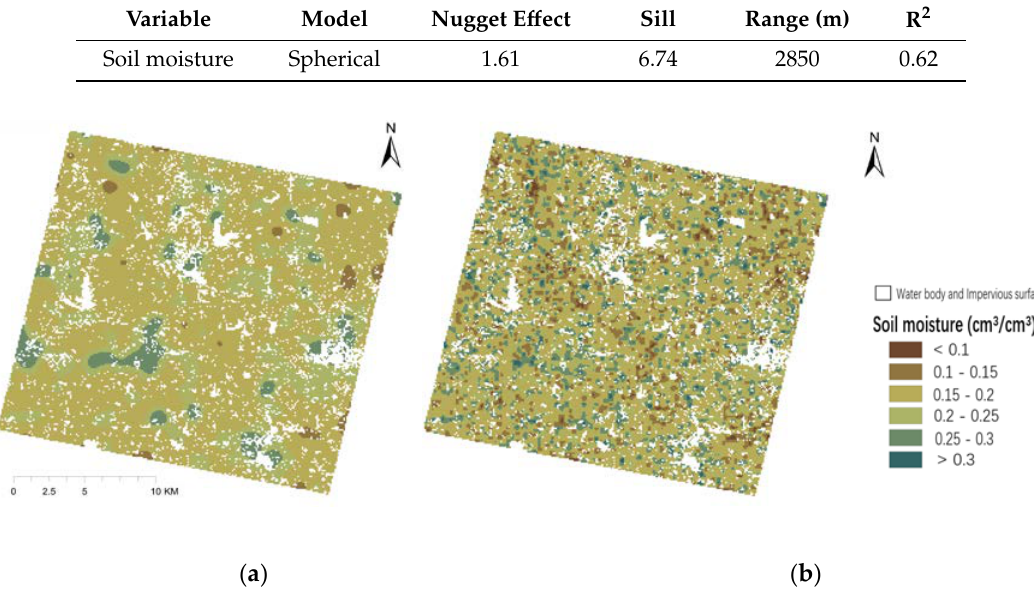
Figure 6. Experimental and fitted theoretical variograms. Table 2. Variogram parameters fitted to the soil moisture sample data.